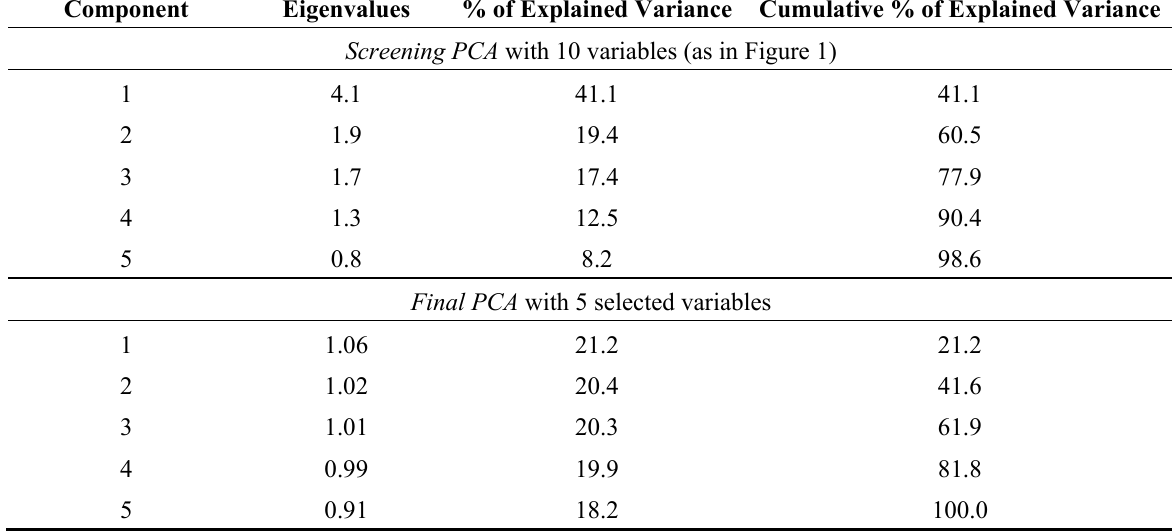
Table 2. Principal Component Analysis (PCA) of the phenological and productivity variables. Statistics for the first five varimax rotated components are shown.